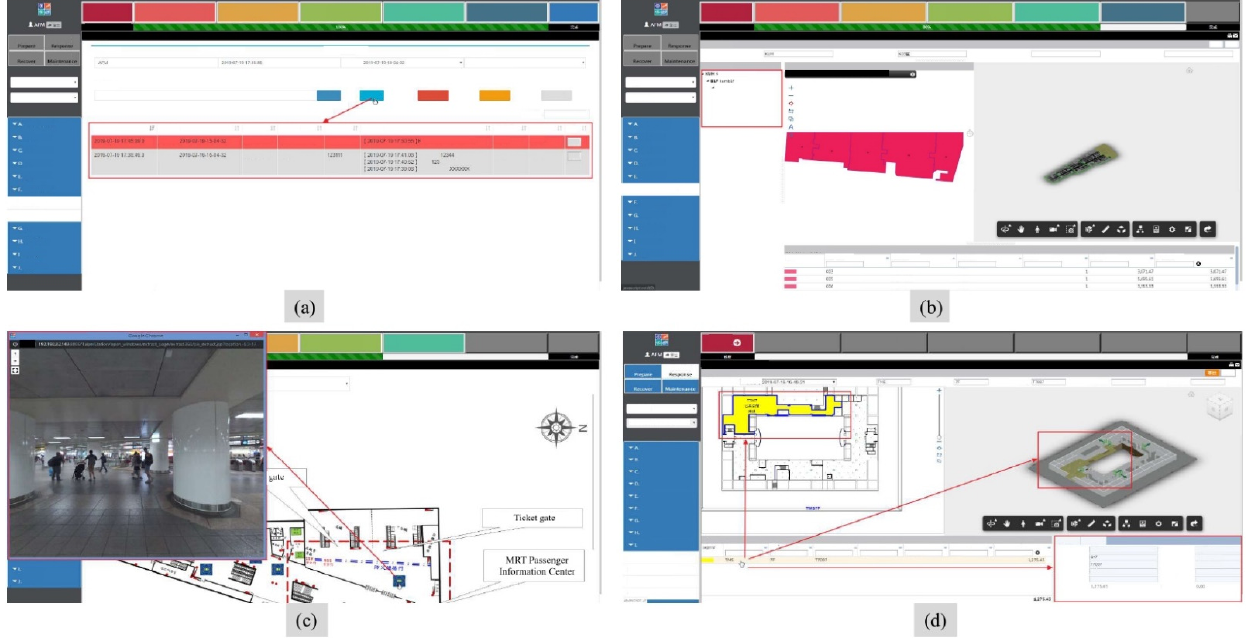
Figure 13. Disaster management: Expanded response procedures. (Source: Research Data). ( a ) Expanded response handling; ( b ) Examine extended areas; ( c ) Buffer area; ( d ) Disaster relief support inquiry.